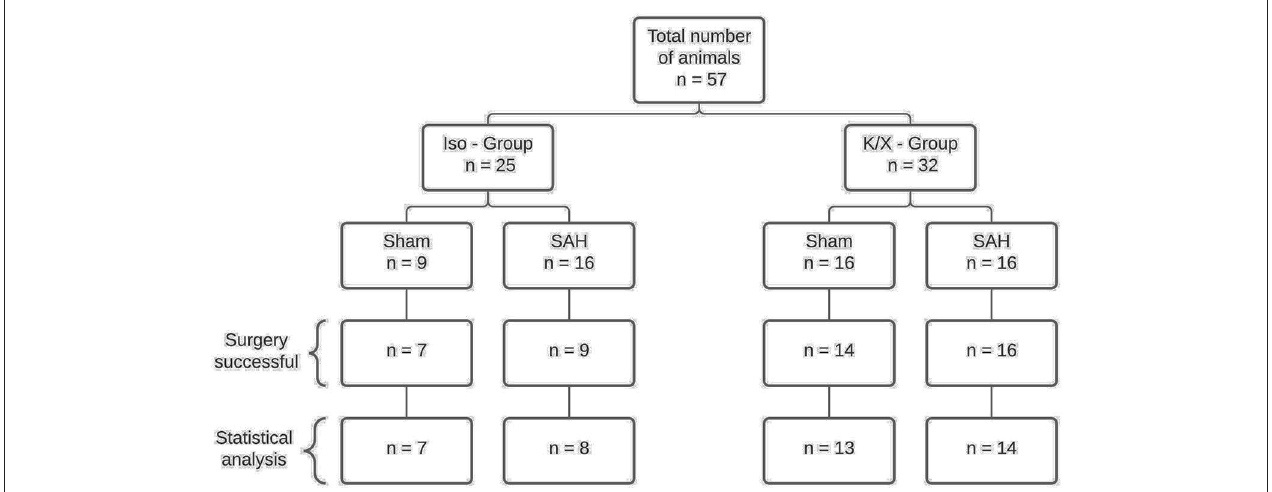
FIGURE 2 | Diagram of sample size distribution. A total of n = 57 animals were allocated to two different anesthesia groups. Within the group, a distinction was made between Sham and SAH. A total of 42 animals were included for statistical analysis. Reasons for exclusion were death during surgery ( n = 11), failed SAH induction ( n = 3), and uncontrollable bleeding from the surgery wound at the cranial window with distortion of CBF measurement ( n = 1); SAH, subarachnoid hemorrhage; Iso, isoflurane; K/X,